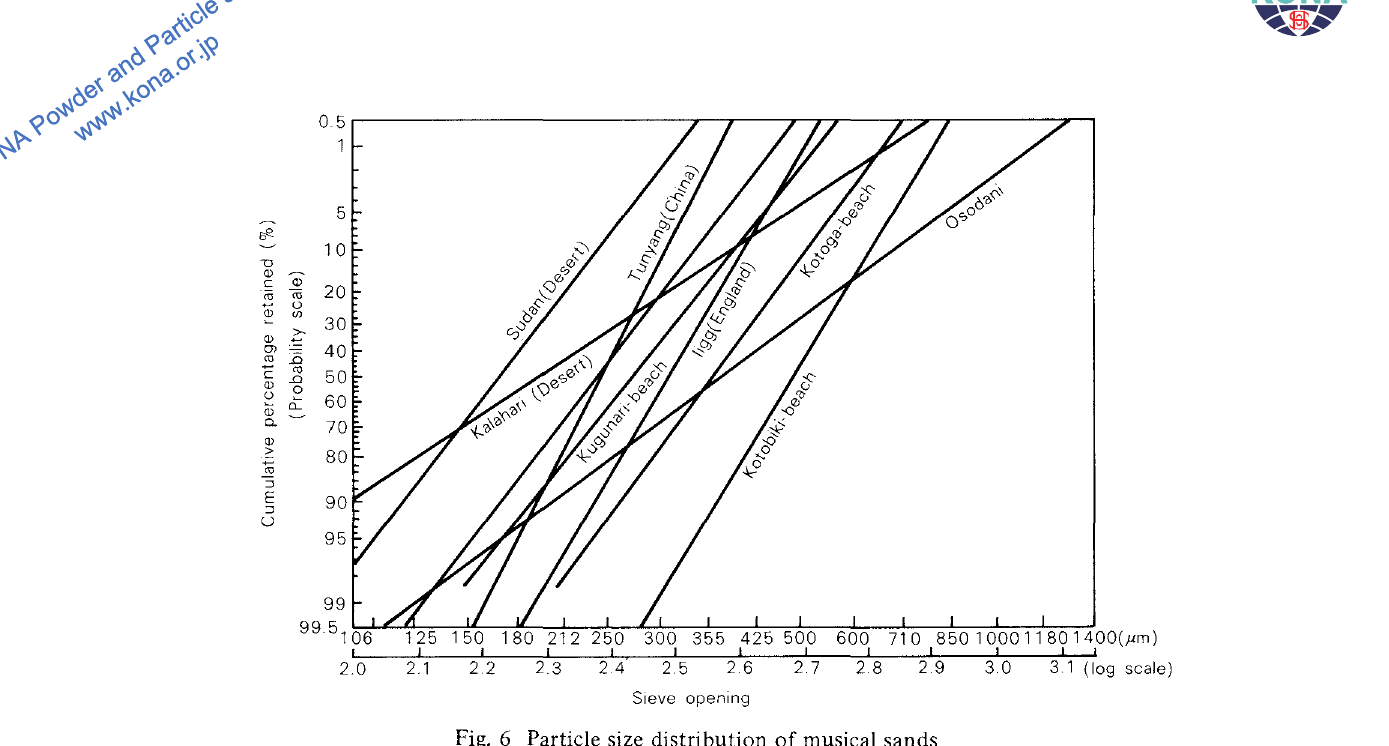
Fig. 6 Particle size distribution of musical sands